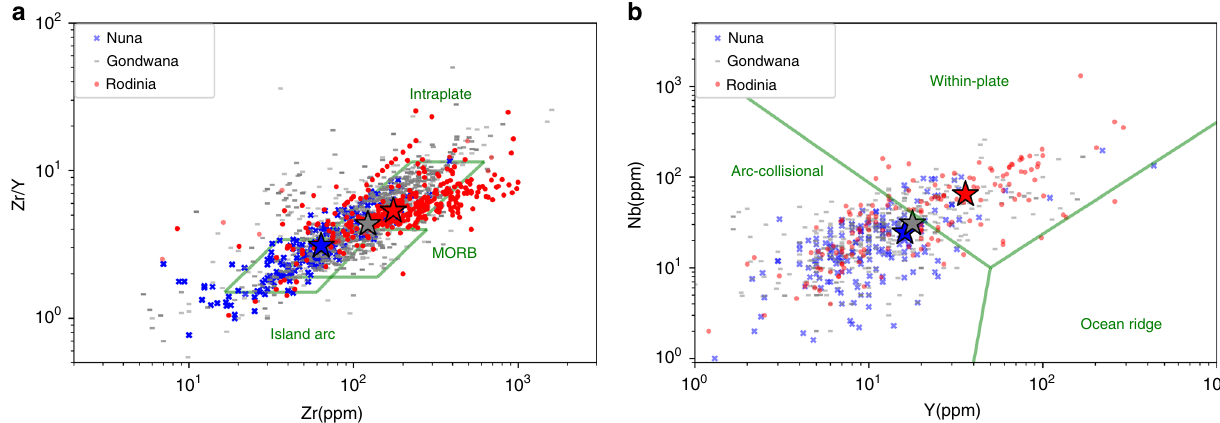
Fig. 3 Tectonic discrimination diagrams. Discrimination diagrams 25,26 for ma fi c ( a ) and felsic ( b ) rocks formed during assemblies of Nuna (blue, x), Rodinia (red fi lled circle), and Gondwana (gray, -) based on concentrations of immobile trace elements. Average values for each supercontinent are plotted as fi lled stars. “ Within-plate/Intraplate ” geochemical signatures are dominant for igneous rocks formed during Rodinia assembly, whereas arc-collisional magmatism is relatively more signi fi cant for Nuna and